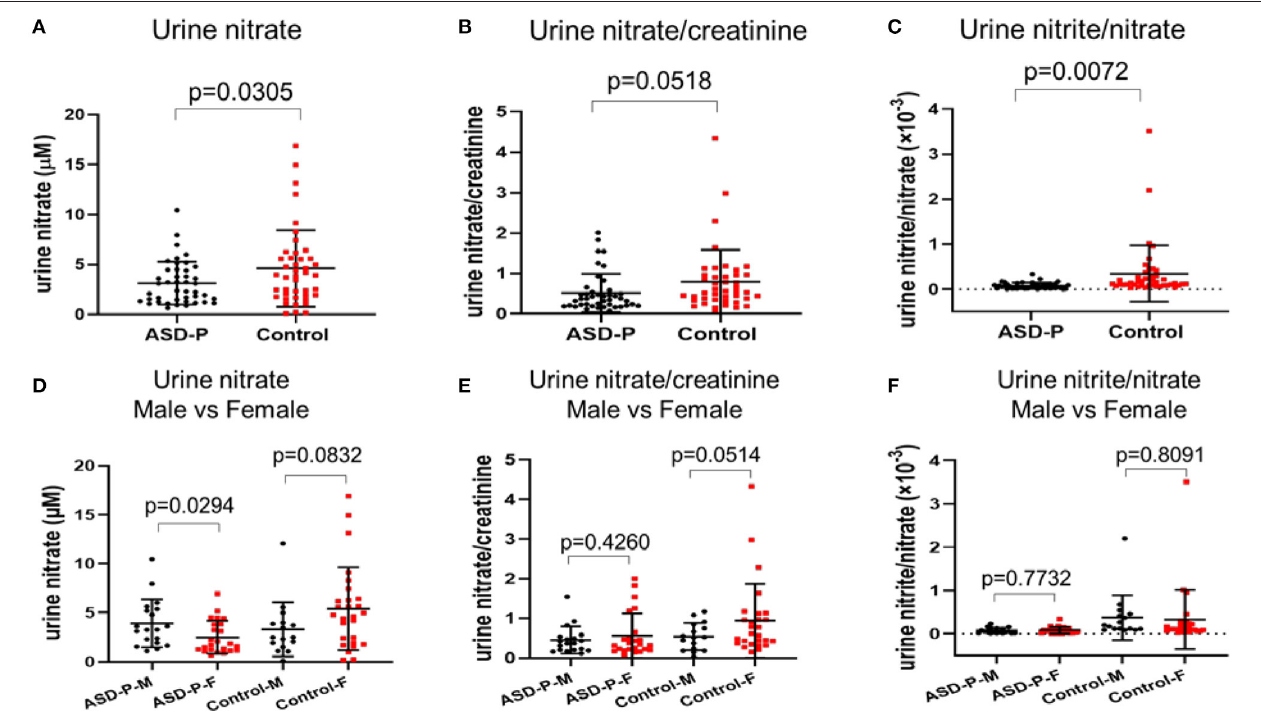
FIGURE 3 | Levels of urine nitrate, nitrate/creatinine and nitrite/nitrate in the ASD-P and Control groups. (A) urine nitrate concentrations in two groups. (B) urine nitrate/creatinine levels in two groups. (C) urine nitrite/nitrate levels in two groups. (D) urine nitrate for male and female participants in each group. (E) urine nitrate/creatinine for male and female participants in each group. (F) urine nitrite/nitrate for male and female participants in each